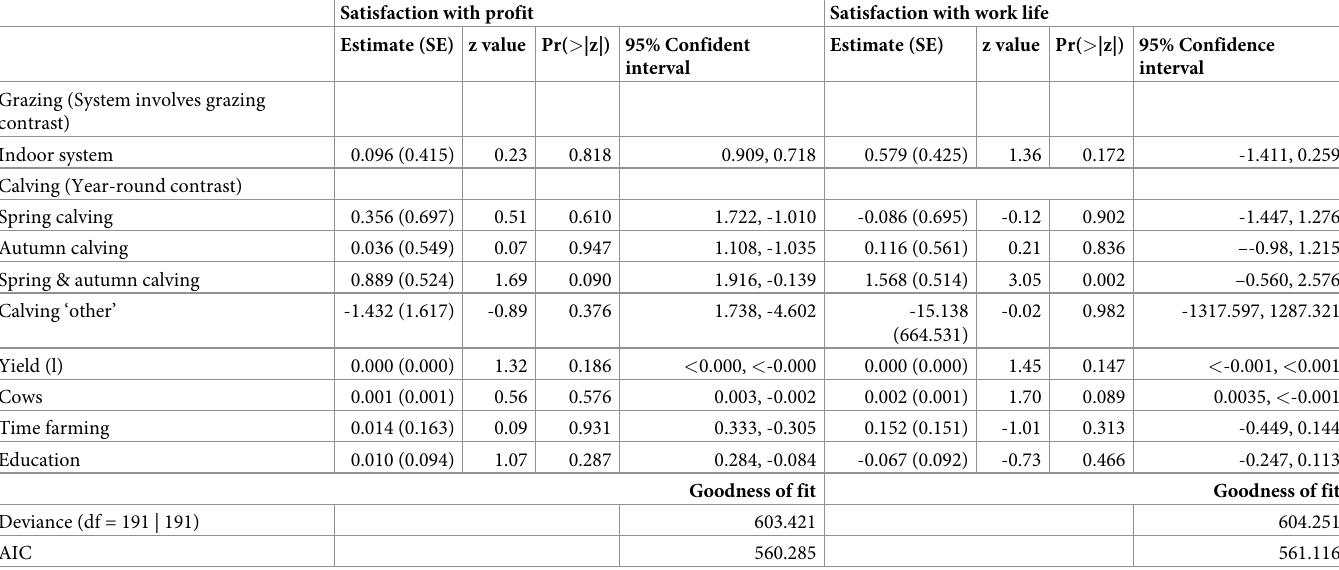
Table 5. Satisfaction with profit (left) and with work life (right)–ordinal model summary